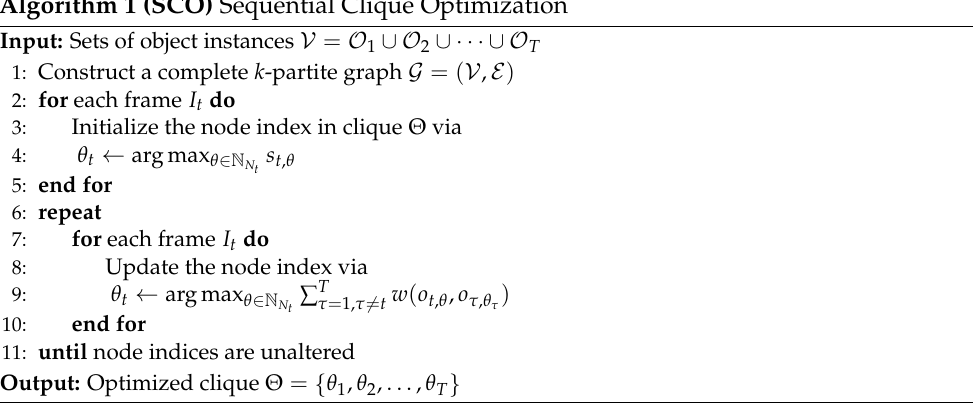
Algorithm 1 (SCO) Sequential Clique